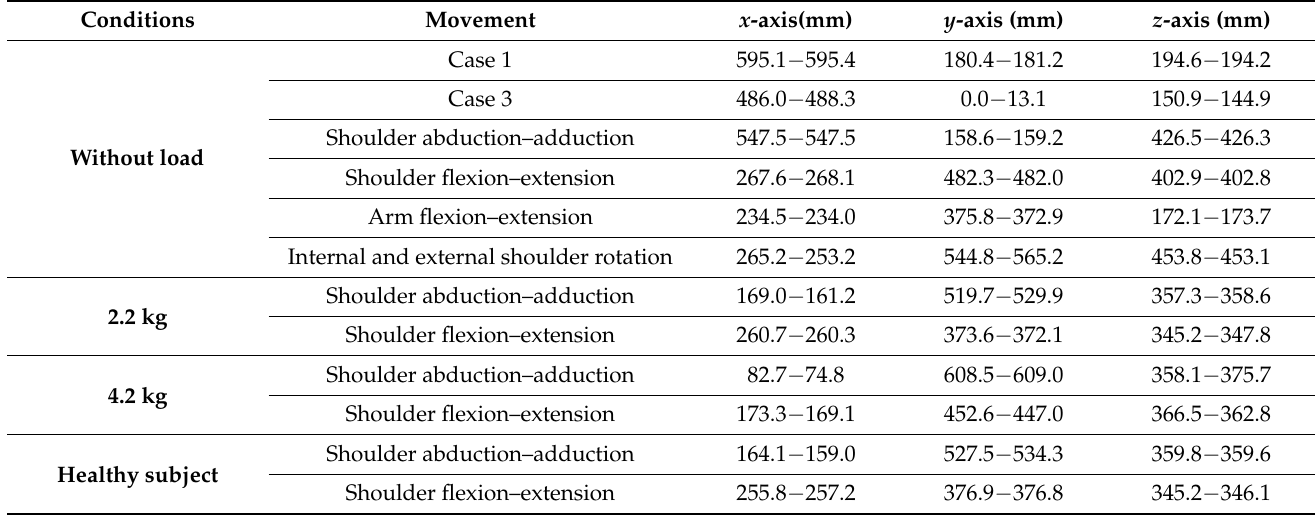
Table 7. RMS values of the ERMIS